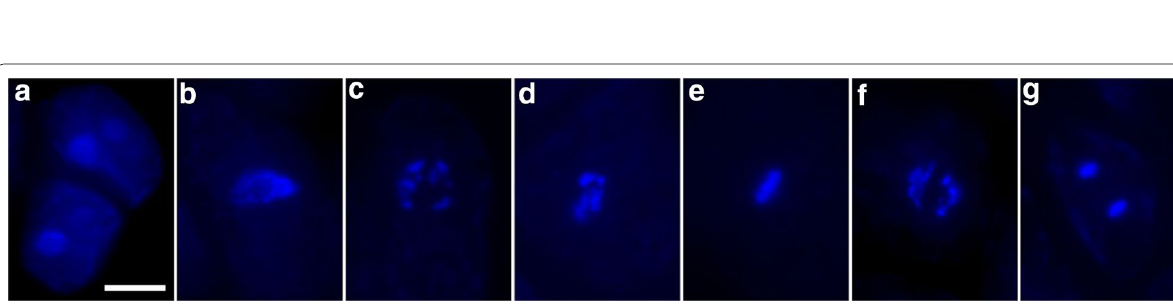
Fig. 2 Process of mitosis in the gametophyte cells of M. angicava . a Interphase, b prophase, c early prometaphase, d late prometaphase, e metaphase, f anaphase, g telophase. Scale bar 5 =